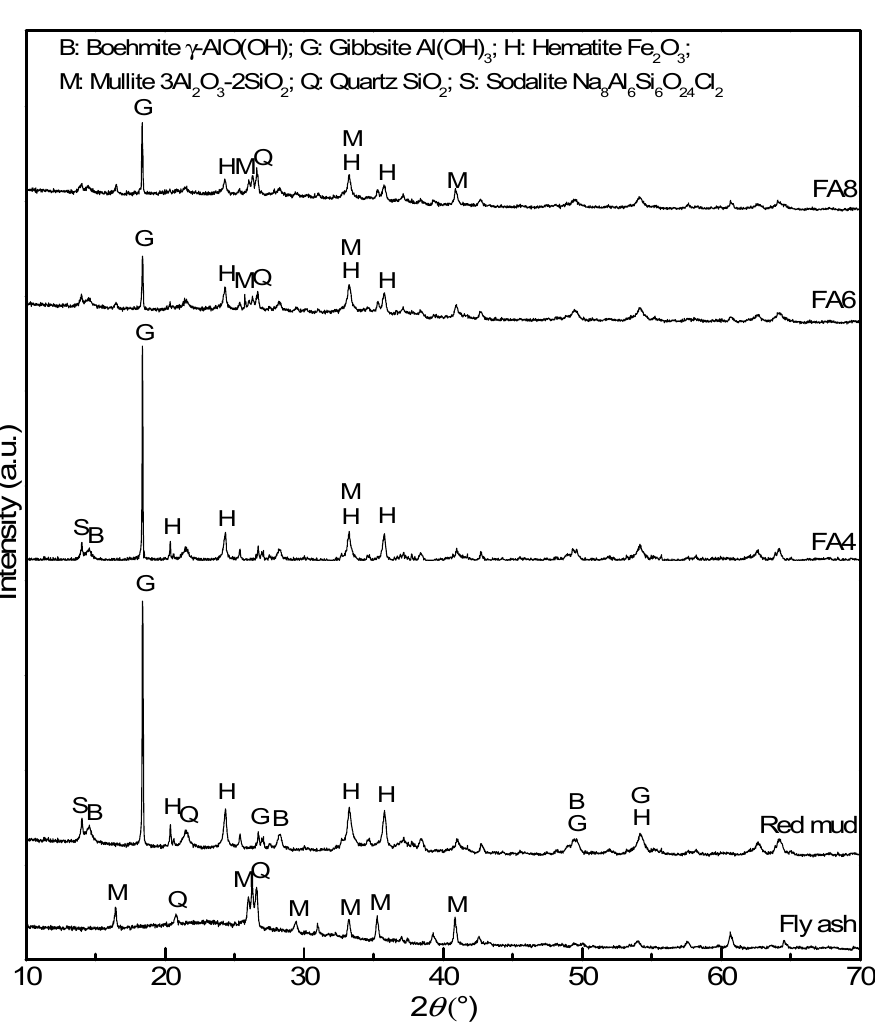
Figure 4. X-ray di ff ractograms of fly ash, red mud, and three geopolymers after 28 Figure 4. X-ray diffractograms of fly ash, red mud, and three geopolymers after 28 days.